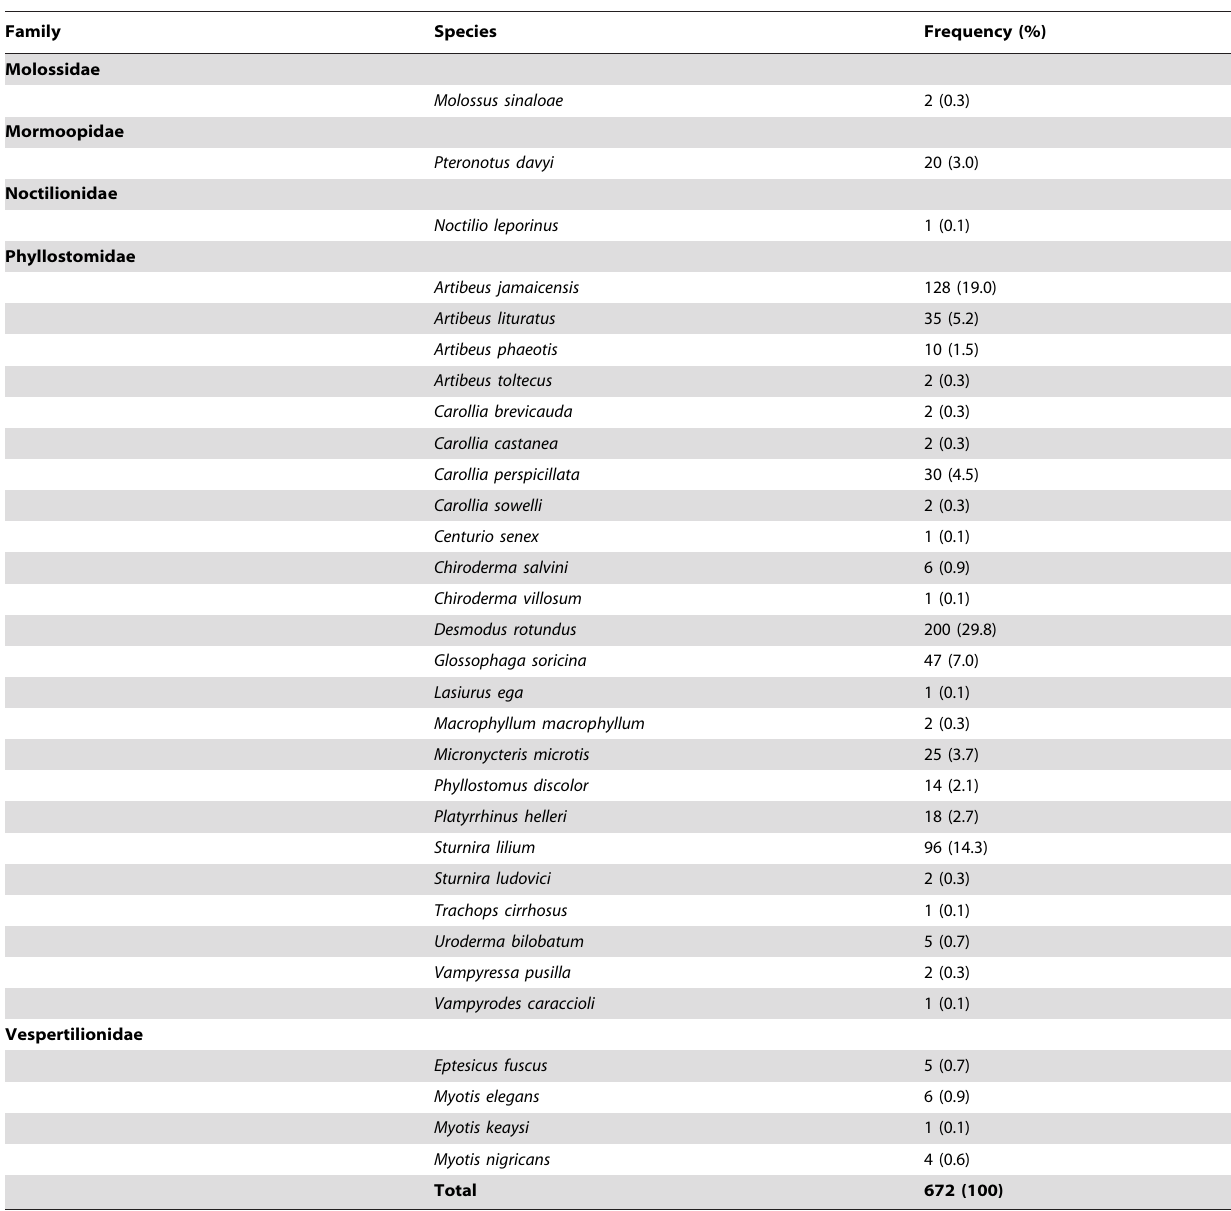
Table 1. Bats collected for rabies testing from 19 field sites in Guatemala, 2009–2011.